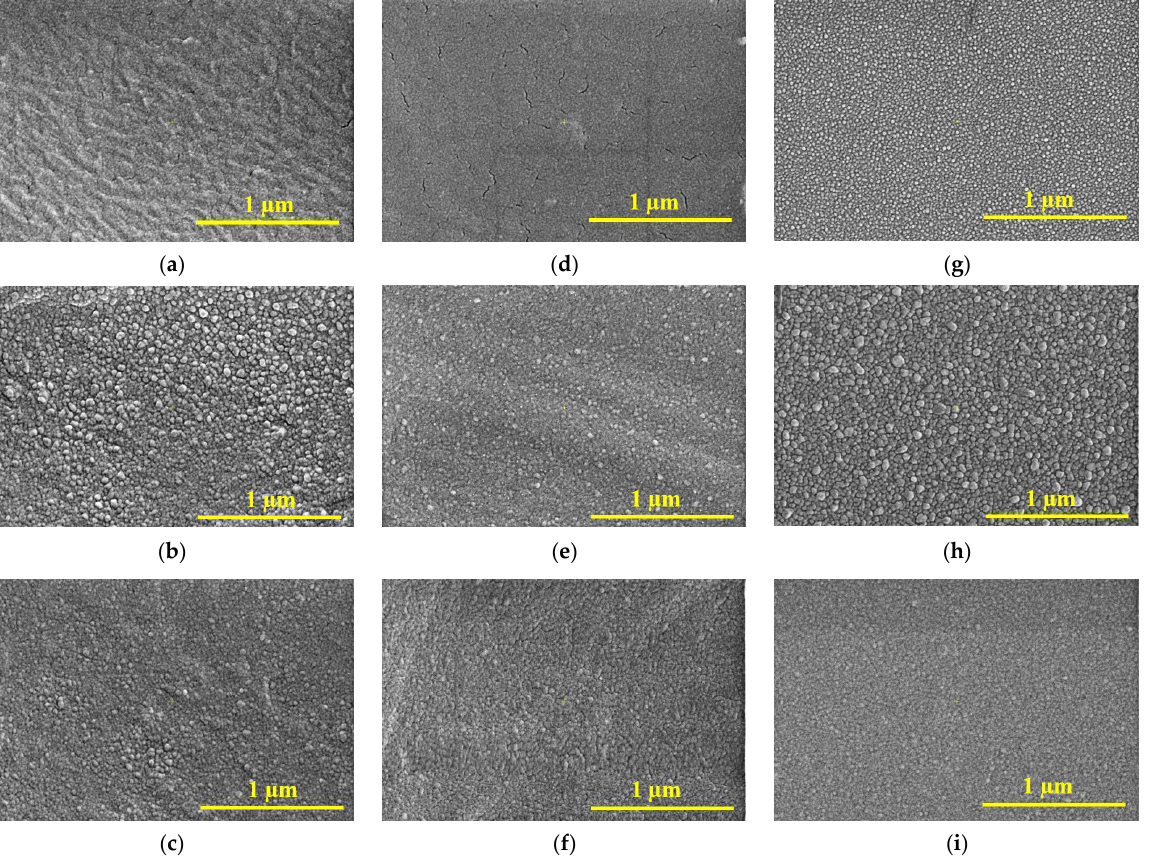
Figure 2. SEM images of as-deposited ultrathin films:( a ) PET-Ag1, ( b ) PET-Ag5, ( c ) PET-Ag9, ( d ) PETs-Ag1, ( e ) PETs-Ag5, ( f ) PETs-Ag9, ( g ) SO-Ag1, ( h ) So-Ag5, ( i ) SO-Ag9.